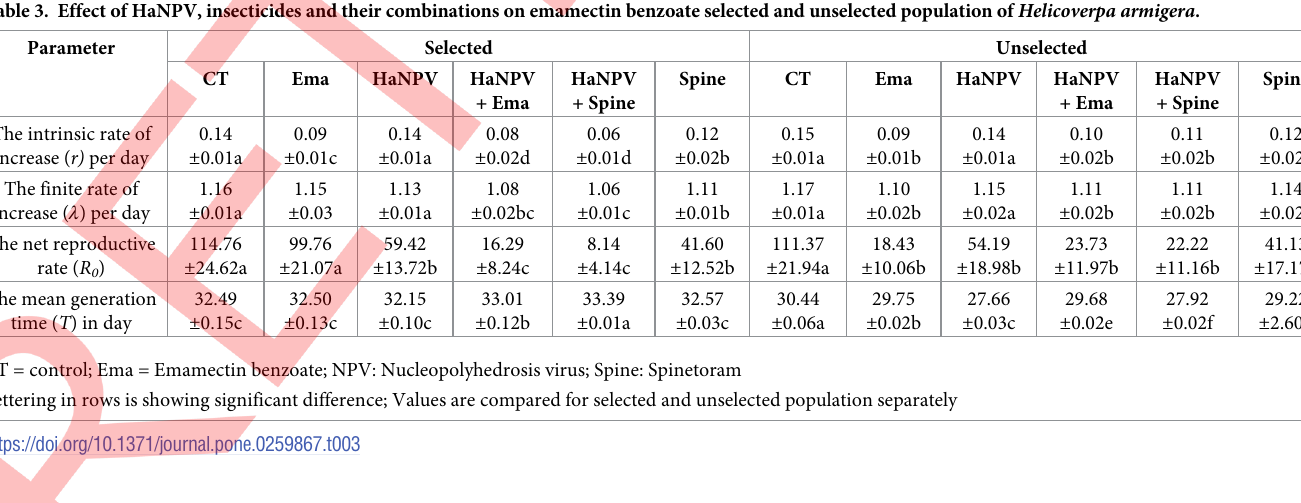
PLOS ONE | https://doi.org/10.1371/journal.pone.0259867 December2,